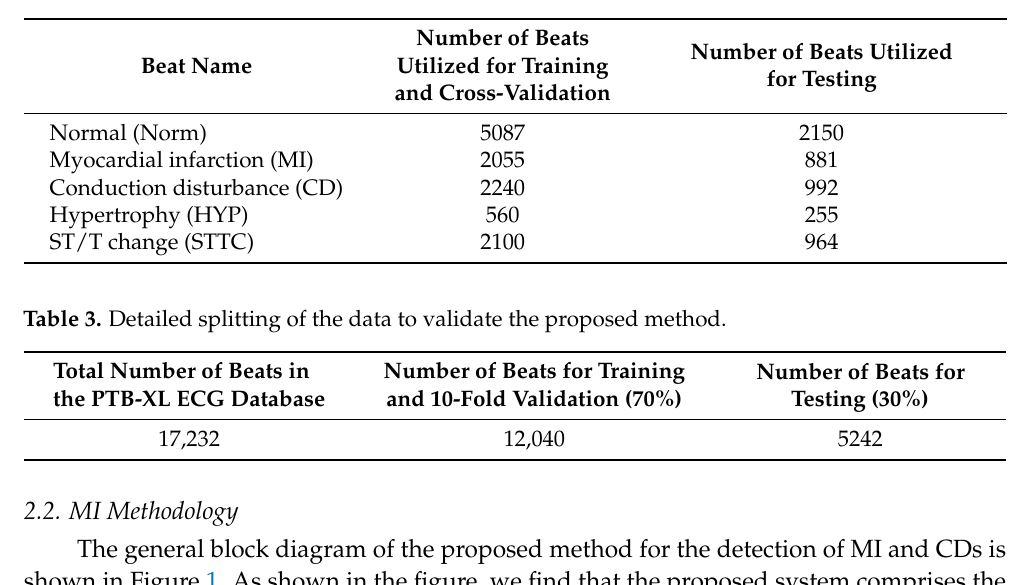
Table 2. Original dataset without multiple annotations.